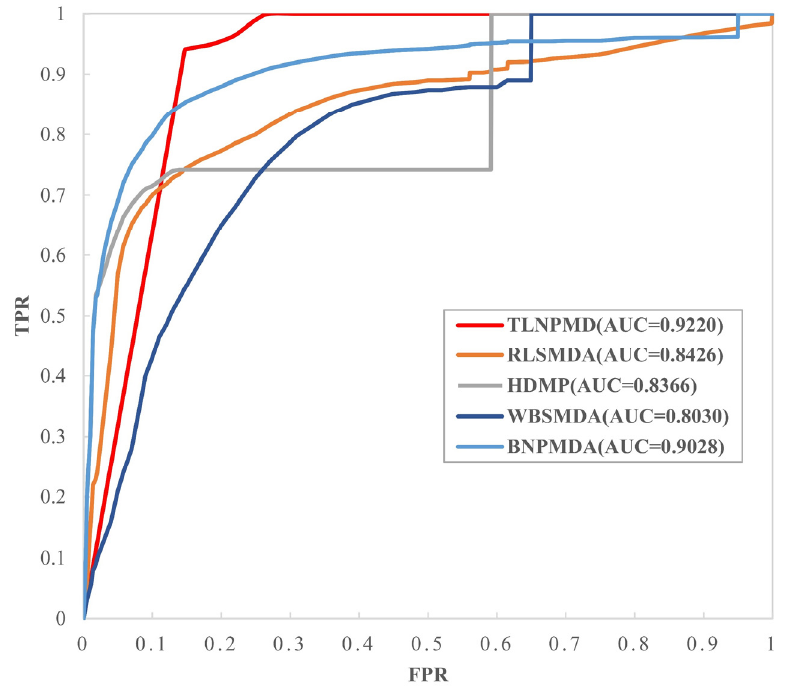
Figure 2. Results of compared models in terms of LOOCV.